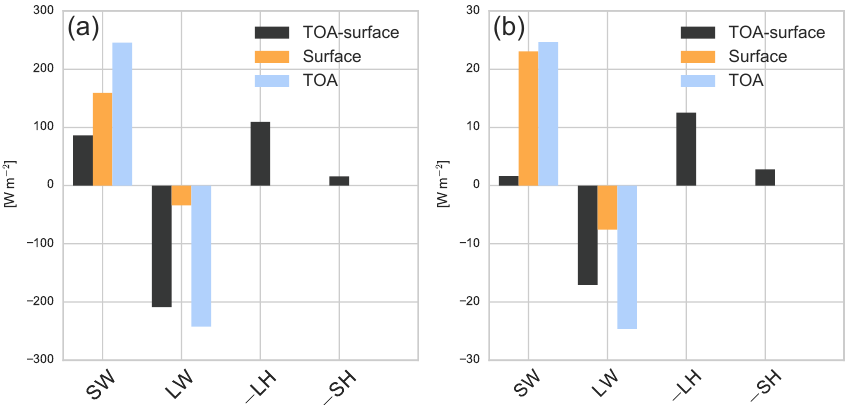
Figure 4. Terms in the global-mean atmospheric energy budget (Eq. 1) for (a) the GHG simulation and (b) change in the LCTC case (LCTC − GHG). The black bars are the atmospheric heating for both